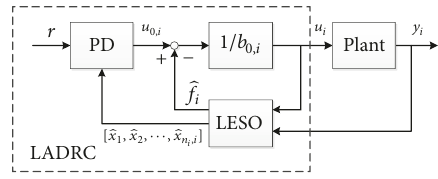
Figure 2: The block diagram of